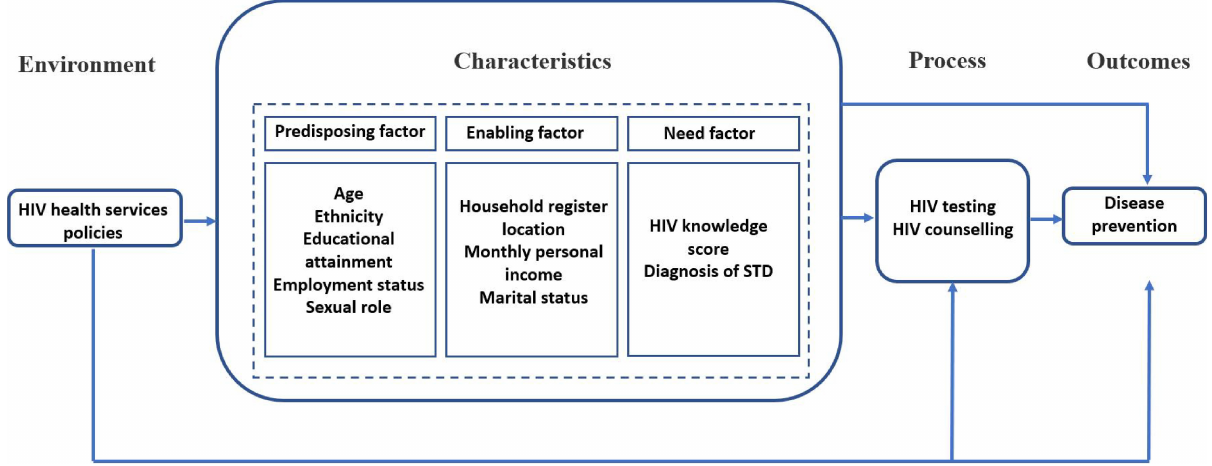
Fig. 1 A diagram of the theoretical framework of Andersen ’ s Behavioral